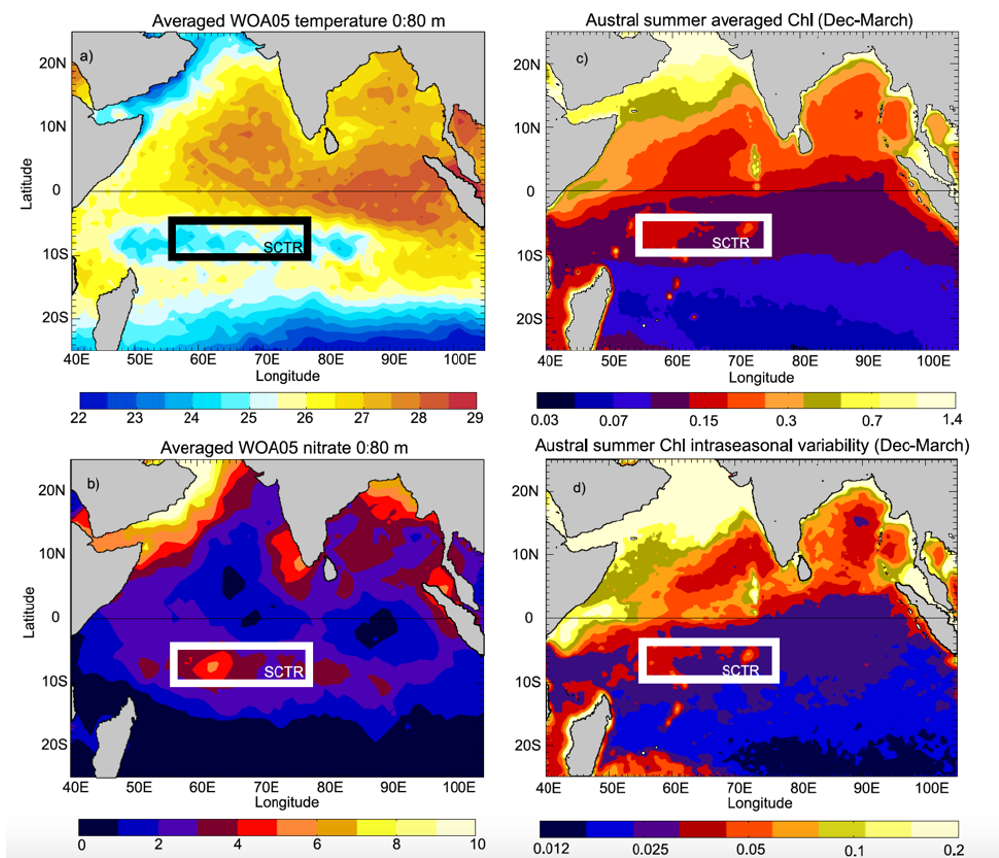
Figure 26. Annual World Ocean Atlas (2005; WOA05 in the figure) (a) temperature and (b) nitrate concentration (in mmolNm − 3 ) averaged between the surface and 80m in the Indian Ocean. (c) SeaWiFS seasonal mean during austral summer (December–March) (mgm − 3 ) . (d) Intraseasonal variability in SeaWiFS chl during austral summer estimated by the averaged rms of (chl − chl ∗ , where chl ∗ is the 2-month moving average) between December and March of the years 1998–2007 (from Resplandy et al.